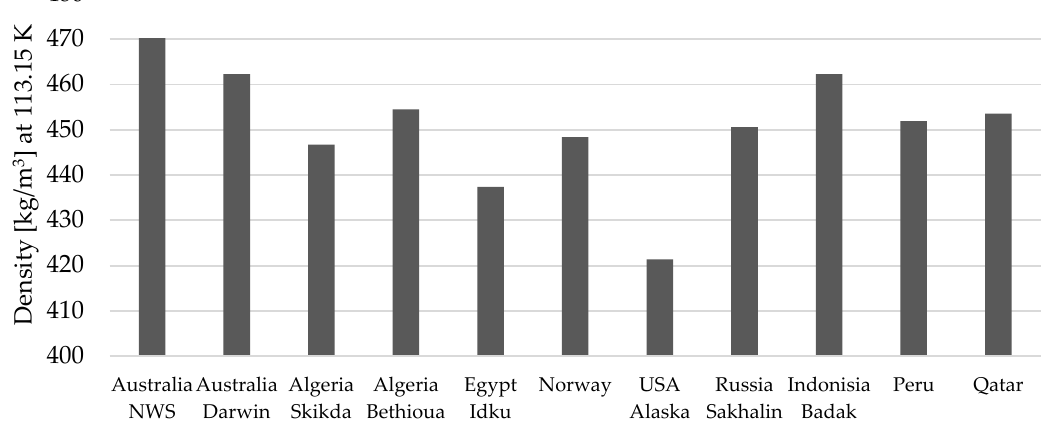
Figure 3. Variations in density per region at 113.15 K.